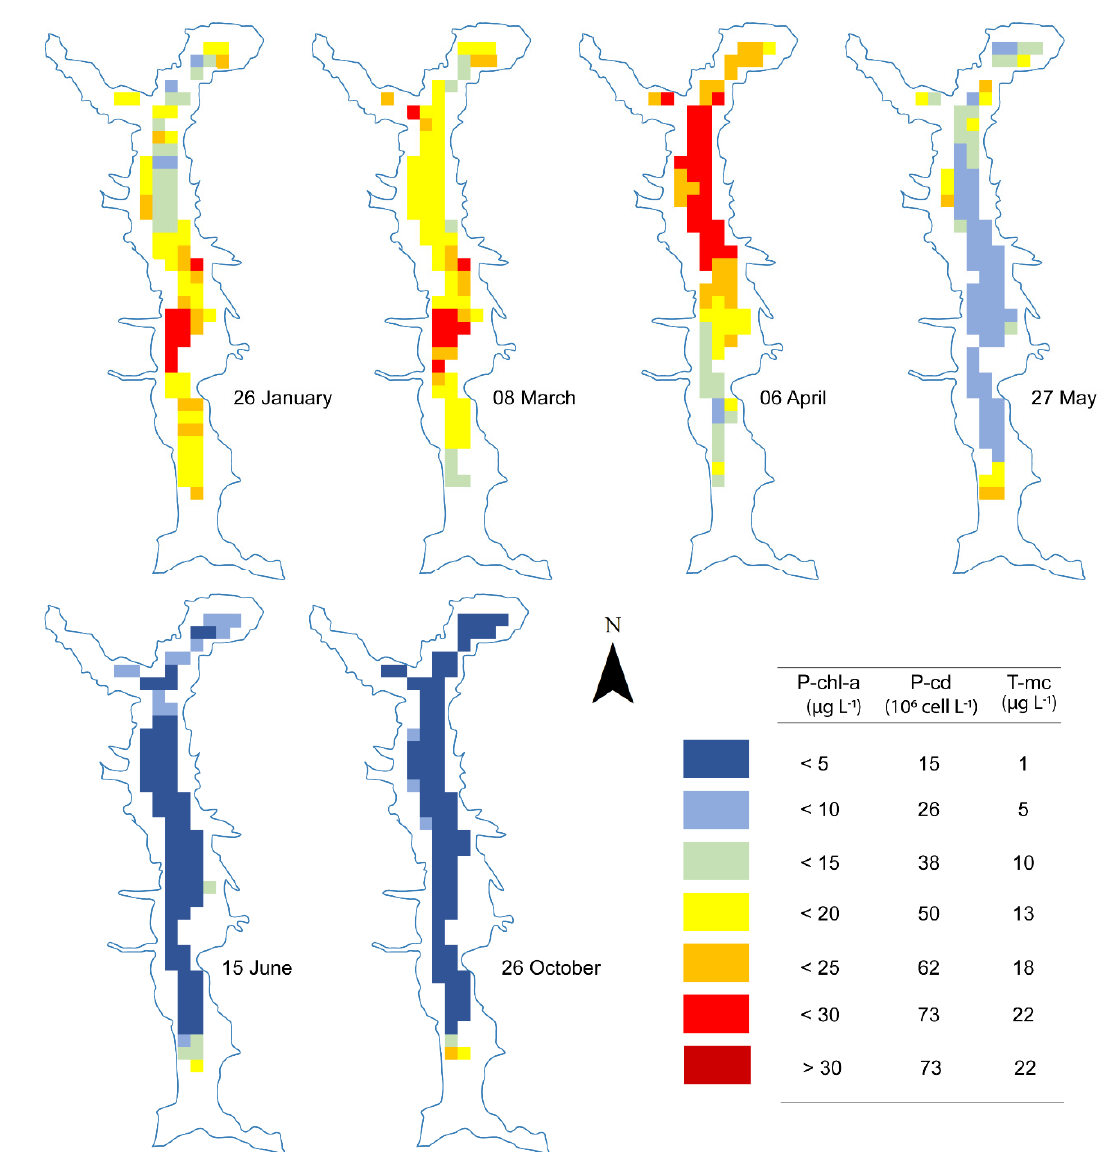
Figure 6. Maps of the P-chl-a (µg L − 1 ) concentrations between the end of January and the end of October 2009. The period covers the beginning and the ending of the bloom. The figure legend also reports the corresponding P. rubescens cell density (P-cd, 106 cell L − 1 ) and total microcystin concentrations (T-mc, µg L − 1 ).